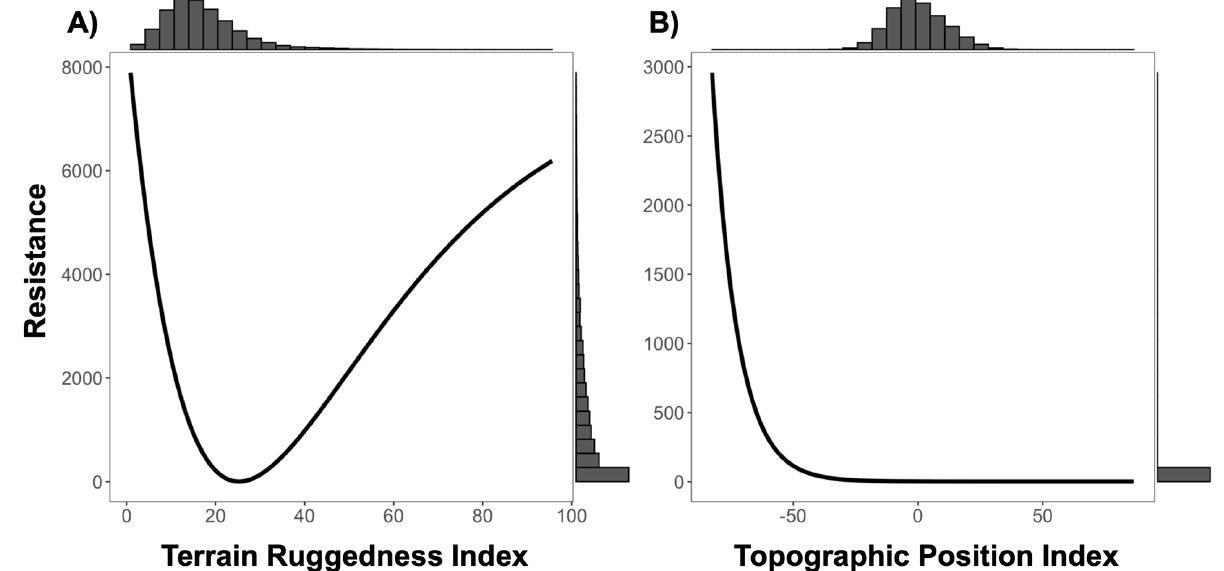
Figure 6. Resistance transformation plot for ‘Composite C’ surface of ( A ) Terrain Ruggedness Index (TRI) and ( B ) canopy height. Low TRI values represent relatively flat terrain and high values represent rugged areas. Resistance to ruffed lemur movement was greater in flat (low value) and rugged (high value) terrain as show in panel ( A ). Canopy height ( B ) was transformed to Distance and, therefore, was non-influential on ruffed lemur movement when evaluating ‘Composite C’ resistance surface.